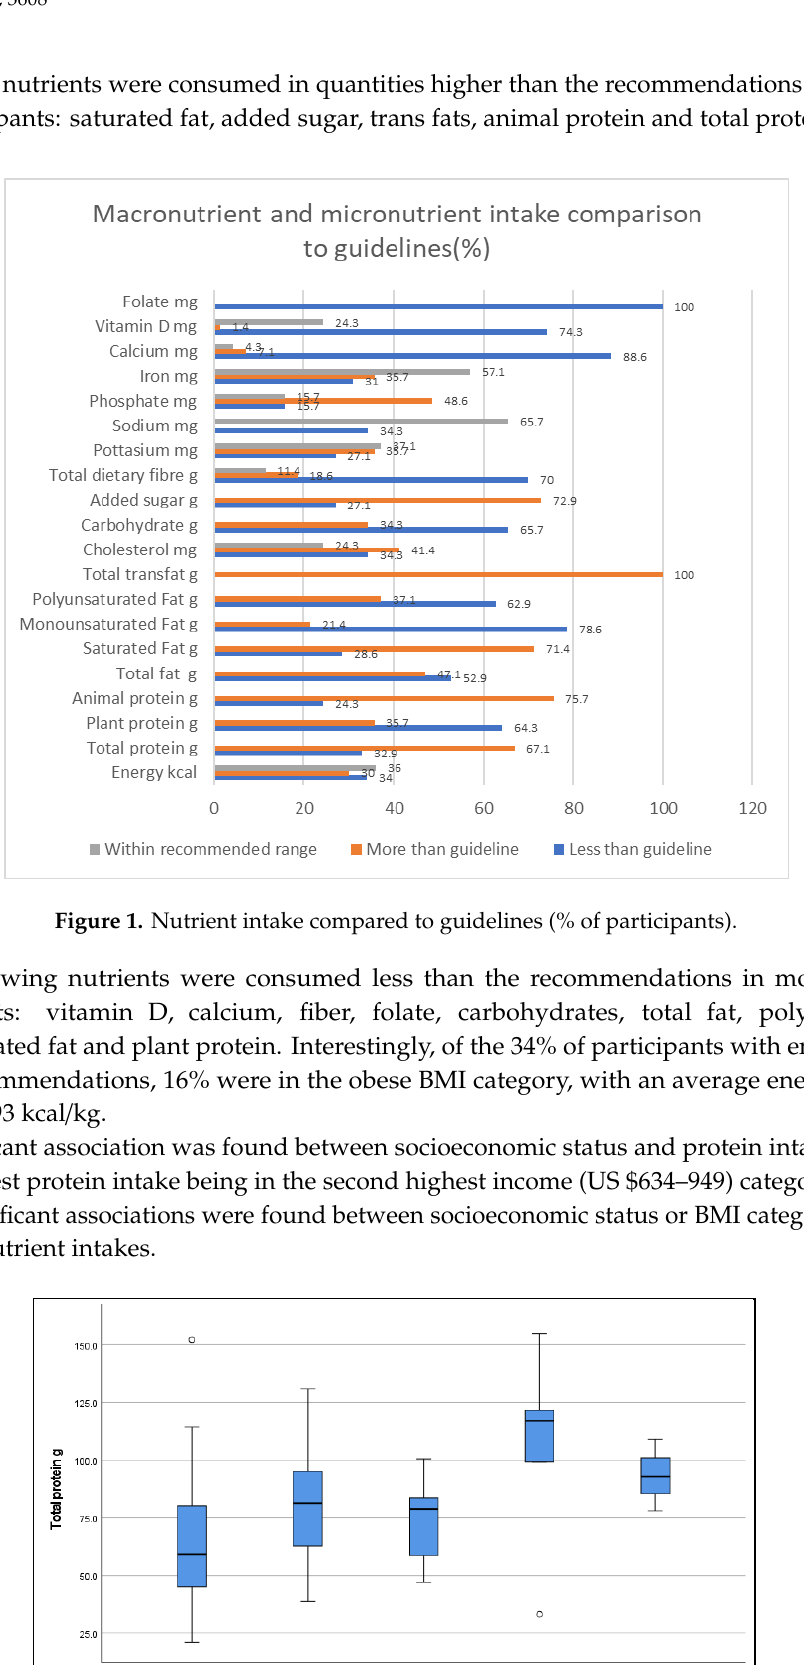
Indicates (cid:35)